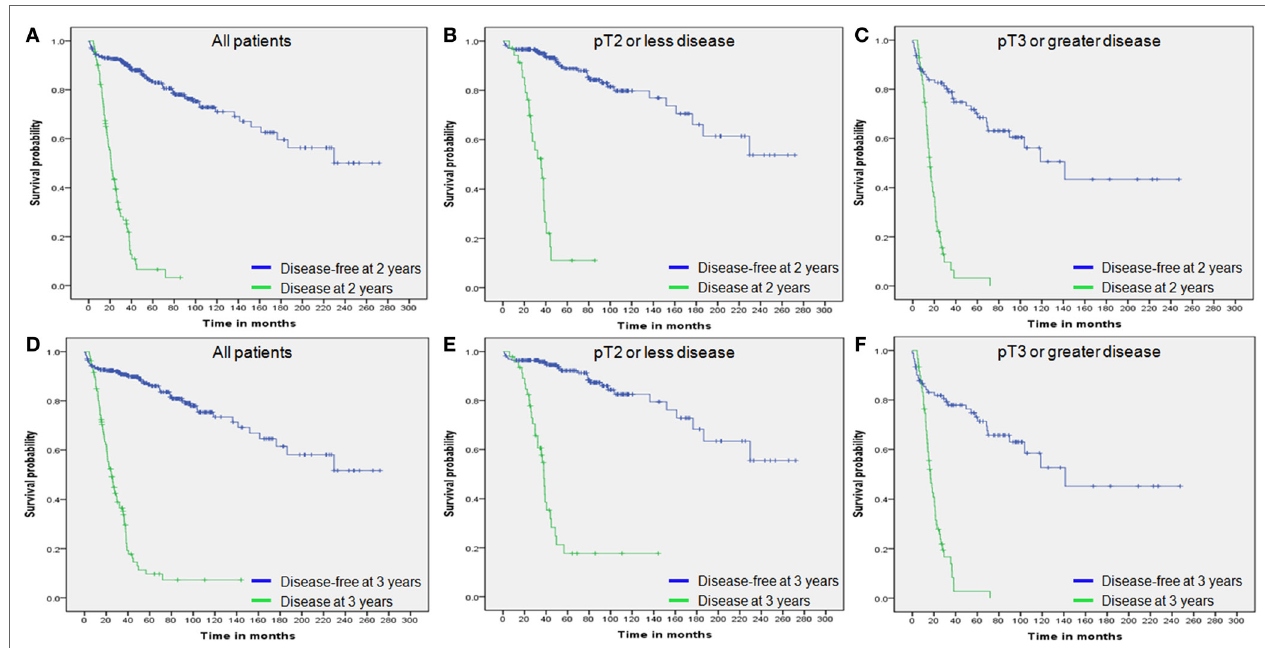
FigUre 2 | Overall survival by disease status . (a) Overall survival of all patients by 2-year disease status. (B) Overall survival of patients with pT2 or less disease by 2-year disease status. (c) Overall survival of patients with pT3 or greater disease by 2-year disease status. (D) Overall survival of all patients by 3-year disease status. (e) Overall survival of patients with pT2 or less disease by 3-year disease status. (F) Overall survival of patients with pT3 or greater disease by 3-year disease status.